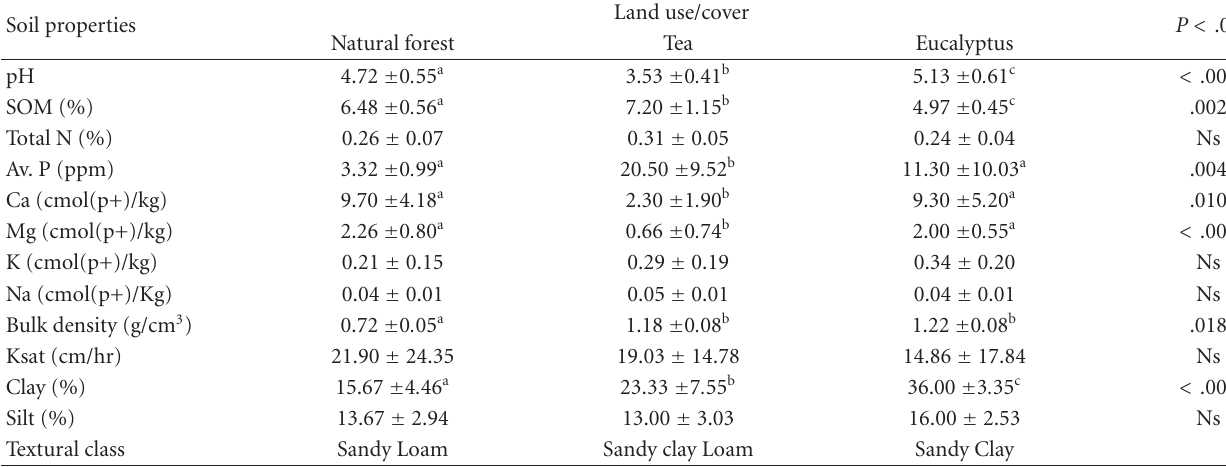
Table 2: Mean ± SD of selected soil (0–15cm) physical and chemical properties in the three land uses. Soil